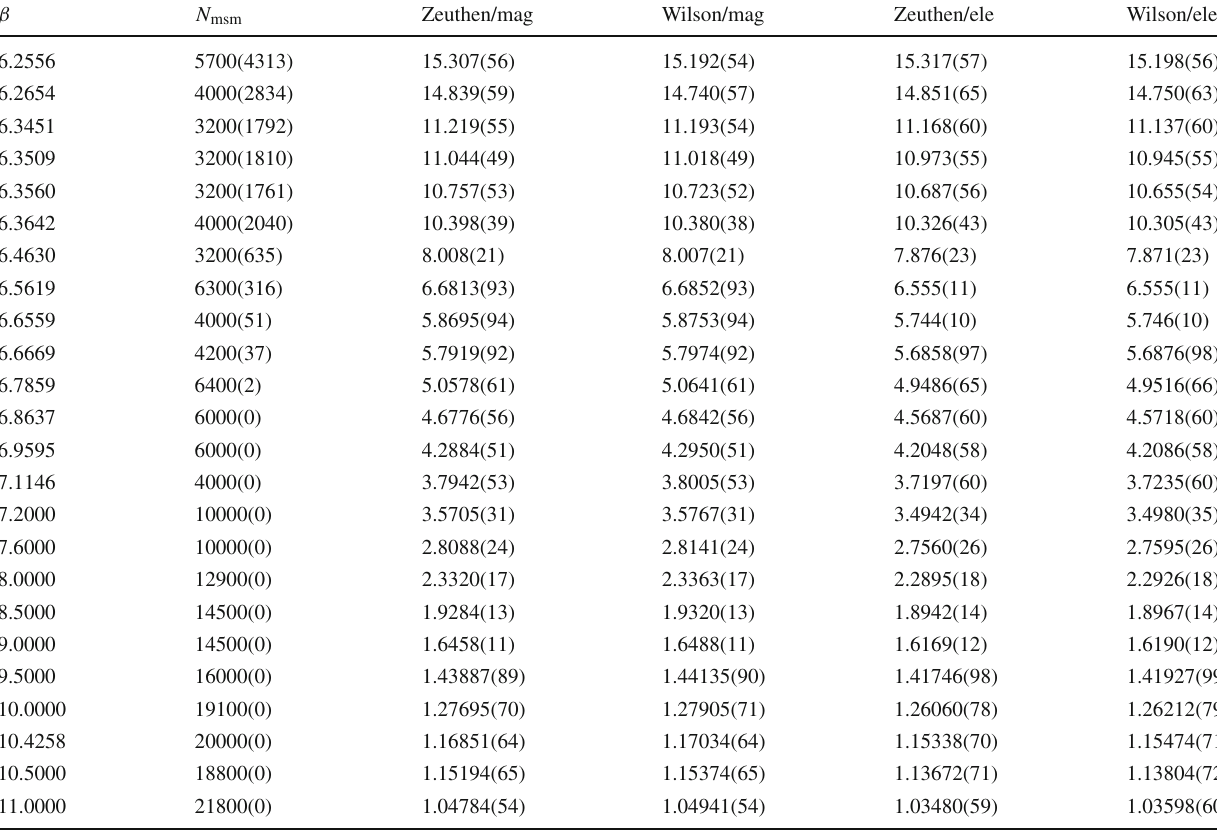
Table 11 GF coupling data for L / a =